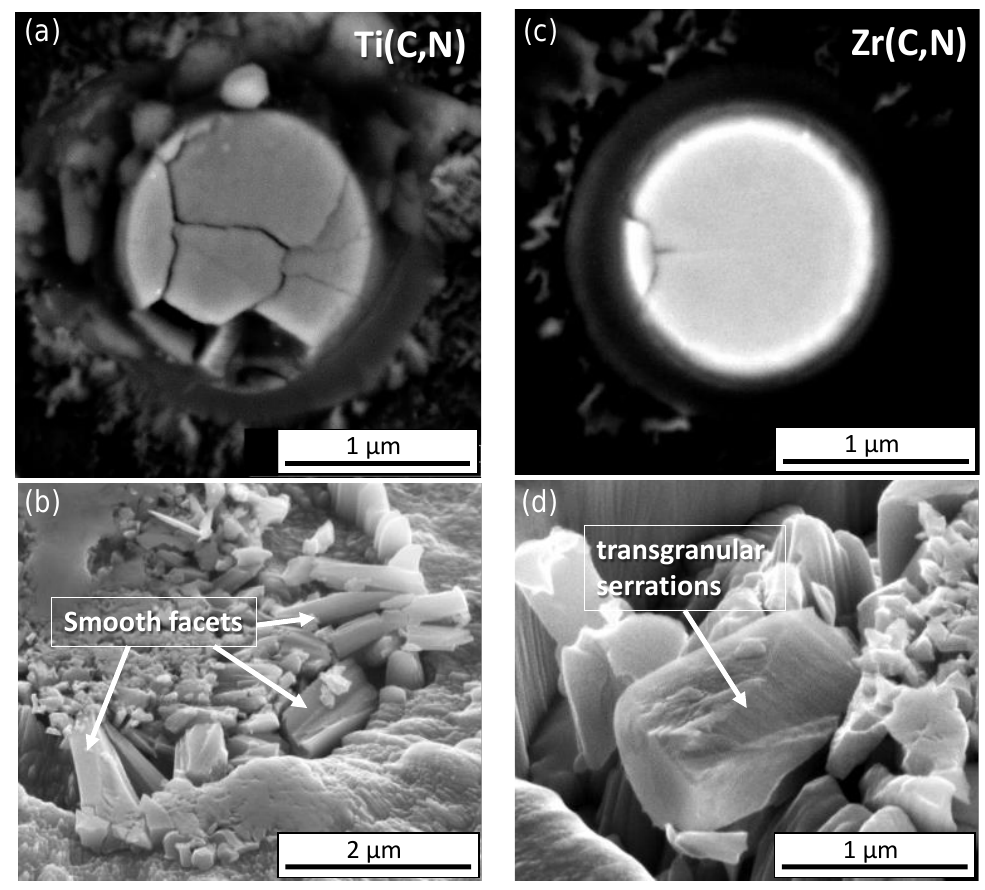
Figure 9. Comparison between failure mechanisms of Ti(C,N) ( a , b ) and Zr(C,N) ( c , d ) micropillars. Initiation of failure at the grain boundaries are noticed in the case of Ti(C,N). After catastrophic failure of micropillars smooth facets for Ti(C,N) grains are observed ( b ), whereas serrations in the Zr(C,N) grains are visible ( d ).